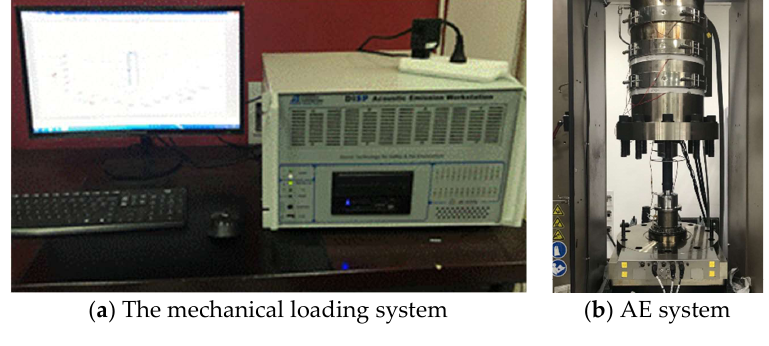
Figure 2. Test setup.